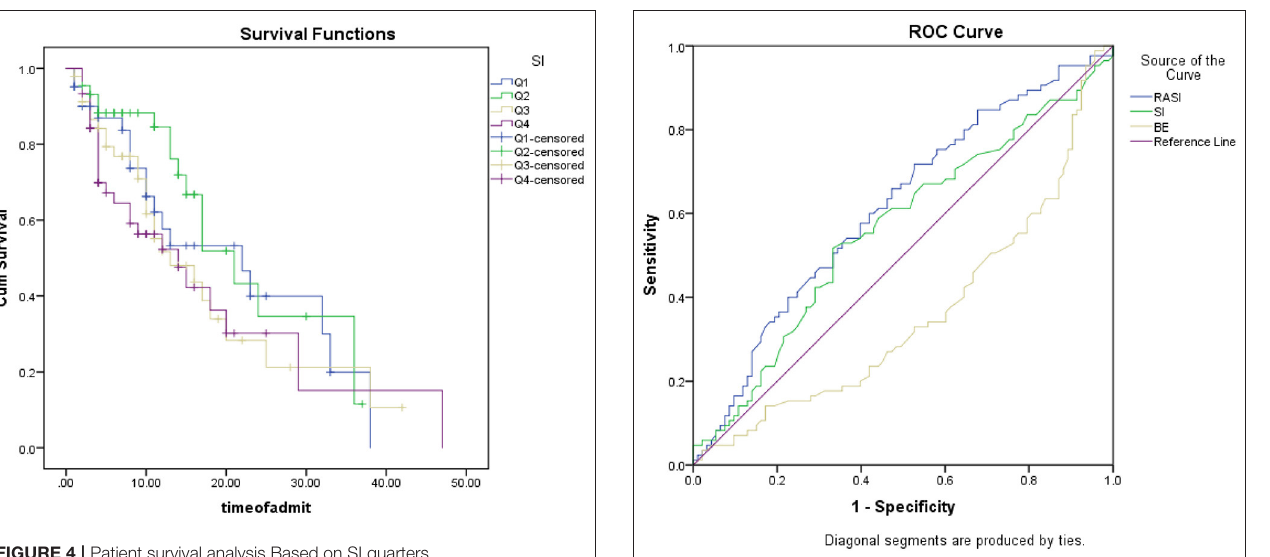
FIGURE 6 | ROC analysis for mortality.